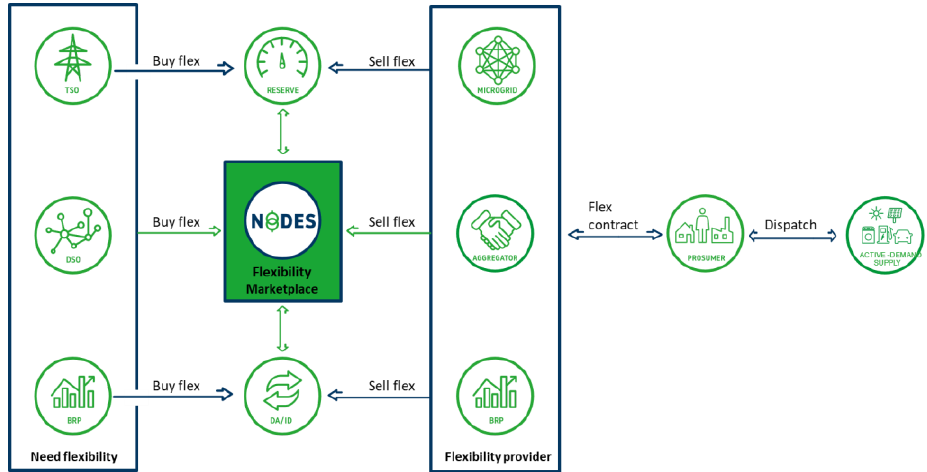
Figure 1. The NODES Flexibility Marketplace concept with the different potential stakeholders [12].